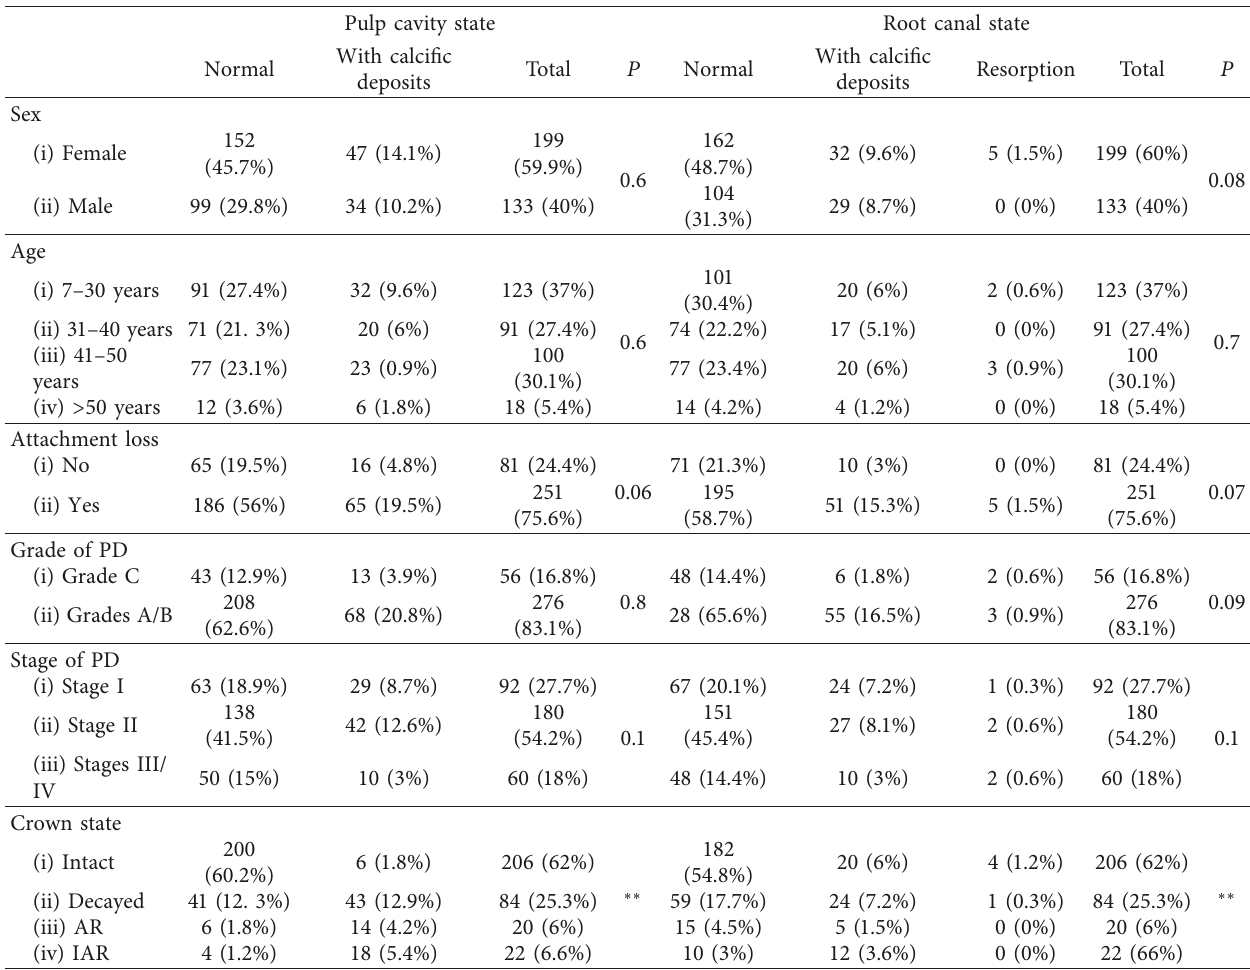
Table 3: Factors associated with the presence of intrapulpal calcifications.